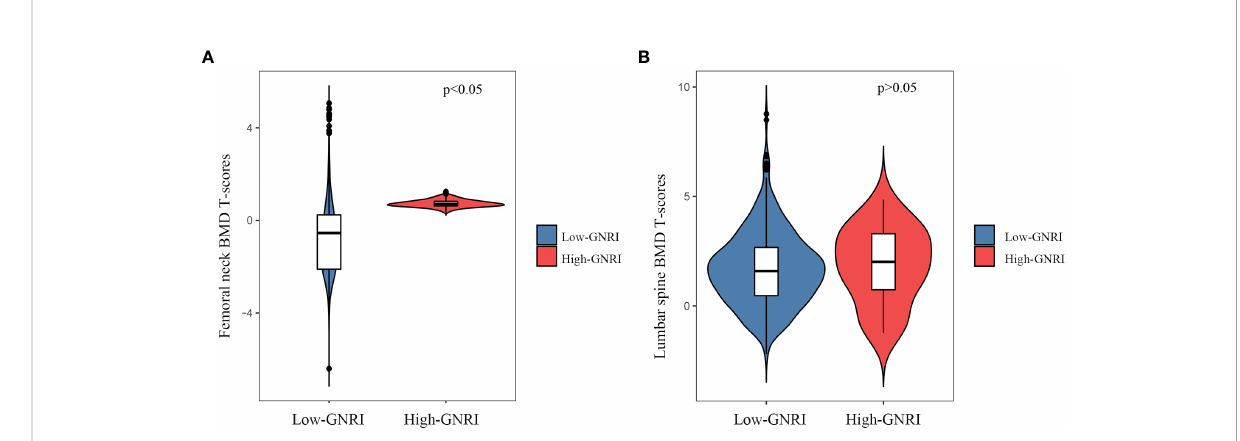
FIGURE 2 The violin plot of BMD T-scores distribution in High-GNRI and Low-GNRI group subjects. (A) Distribution of femoral neck BMD T-scores in two groups. (B) Distribution of lumbar BMD T-scores in two